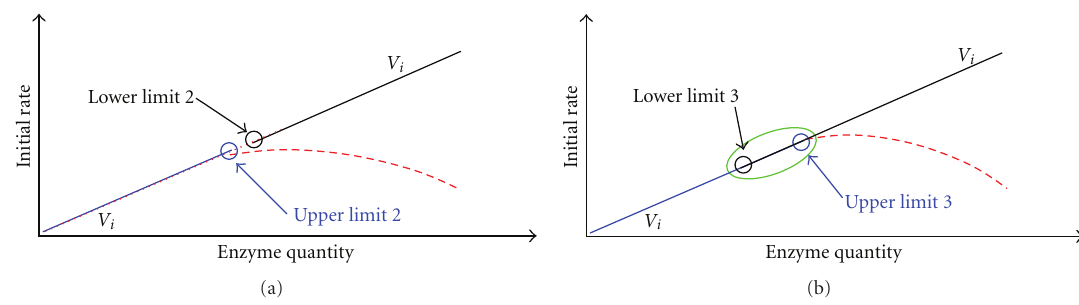
Figure 3: Optimizations of both S 0 to increase the upper limit of the classical initial rate method and reaction duration to reduce the lower limit by kinetic analysis of reaction curve for meeting the second prerequisite for an integration strategy to quantify an enzyme ( V i ).